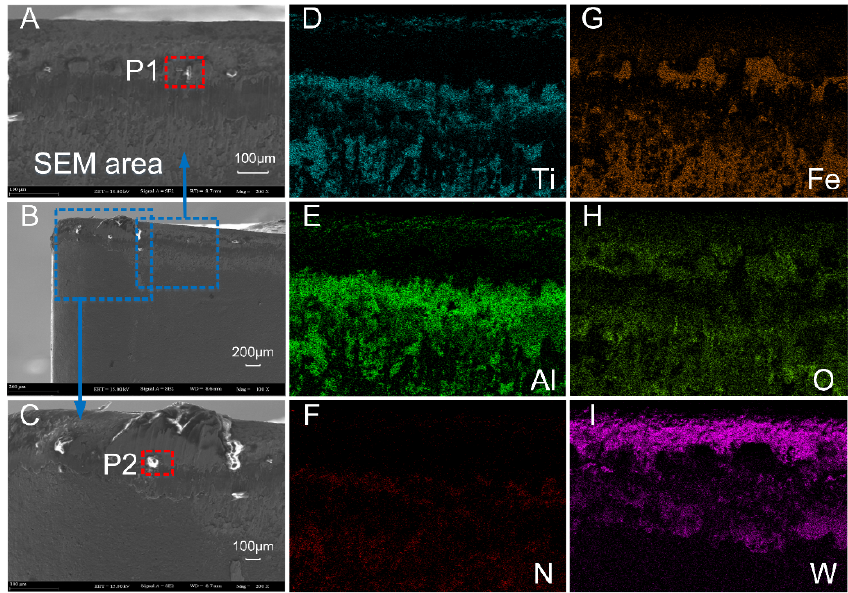
Figure 15. ( A – C ) The flank face wear of Tool A after 70 min of cutting. ( D – I ) Distribution of main elements.